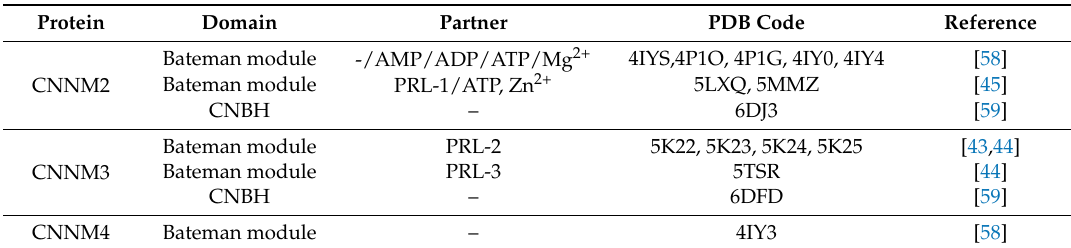
Table 3. Available structural data on the CNNM